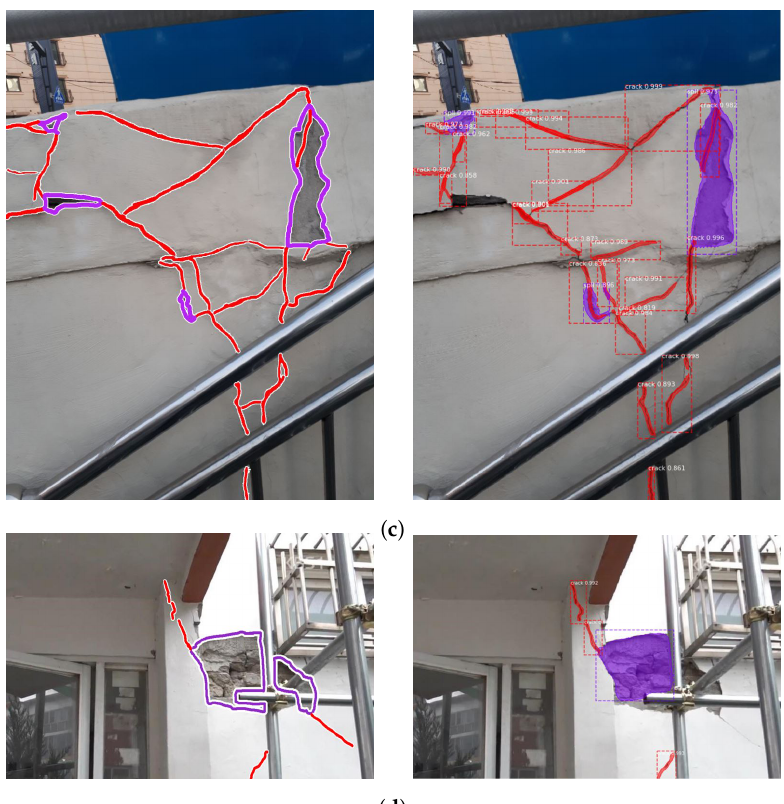
Figure 8. Examples of collocated damage detection results (left column: original images with ground truth, right column: detection result of trained Mask R-CNN): ( a ) detection result of Collocated damages-5 in Table 1, ( b ) detection result of Collocated damages-10 in Table 1, ( c ) detection result of Collocated damages-7 in Table 1 and ( d )detection result of Collocated damages-2 in Table